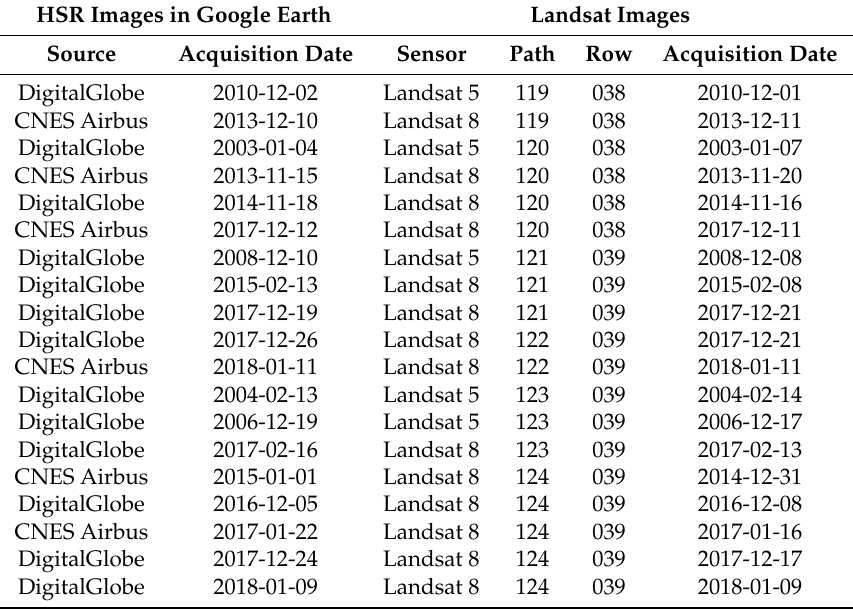
Table 1. High Spatial Resolution (HSR) images and spatially corresponding Landsat images for accuracy assessment.